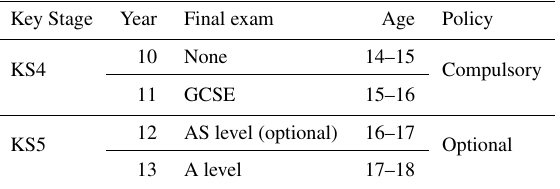
Table B1. Summary of the stages in the English education system applicable to